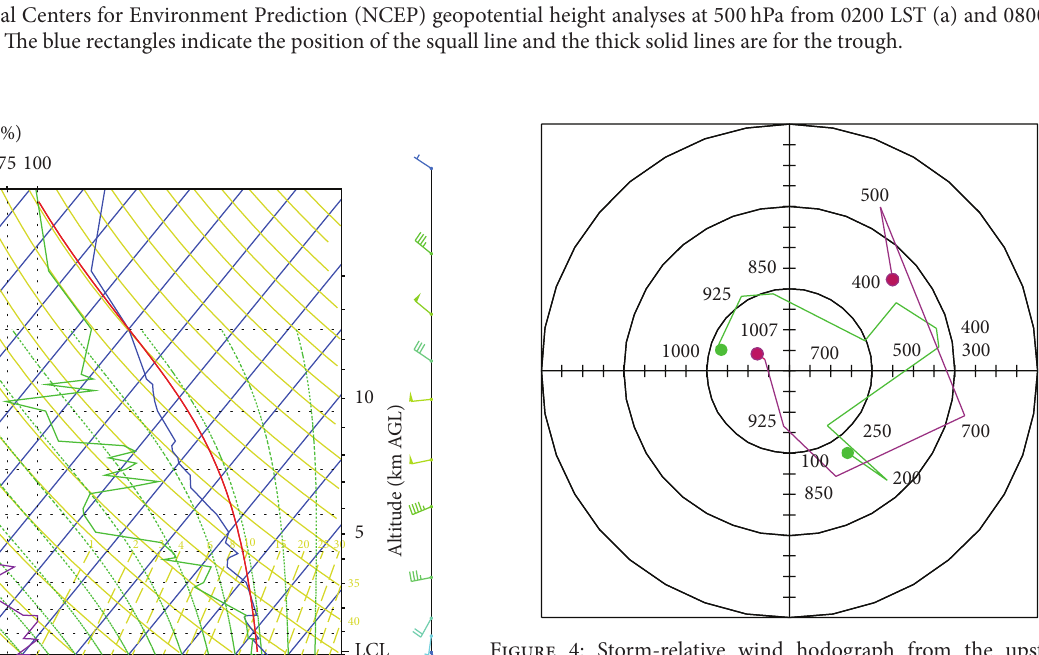
Figure 4: Storm-relative wind hodograph from the upstream sounding (Qingyuan: magenta line) and downstream sounding (Hong Kong: green line) at 0800 LST 24 April 2007. Every ring presents 20 knots of increment in speed, and the numbers indicate the pressure levels